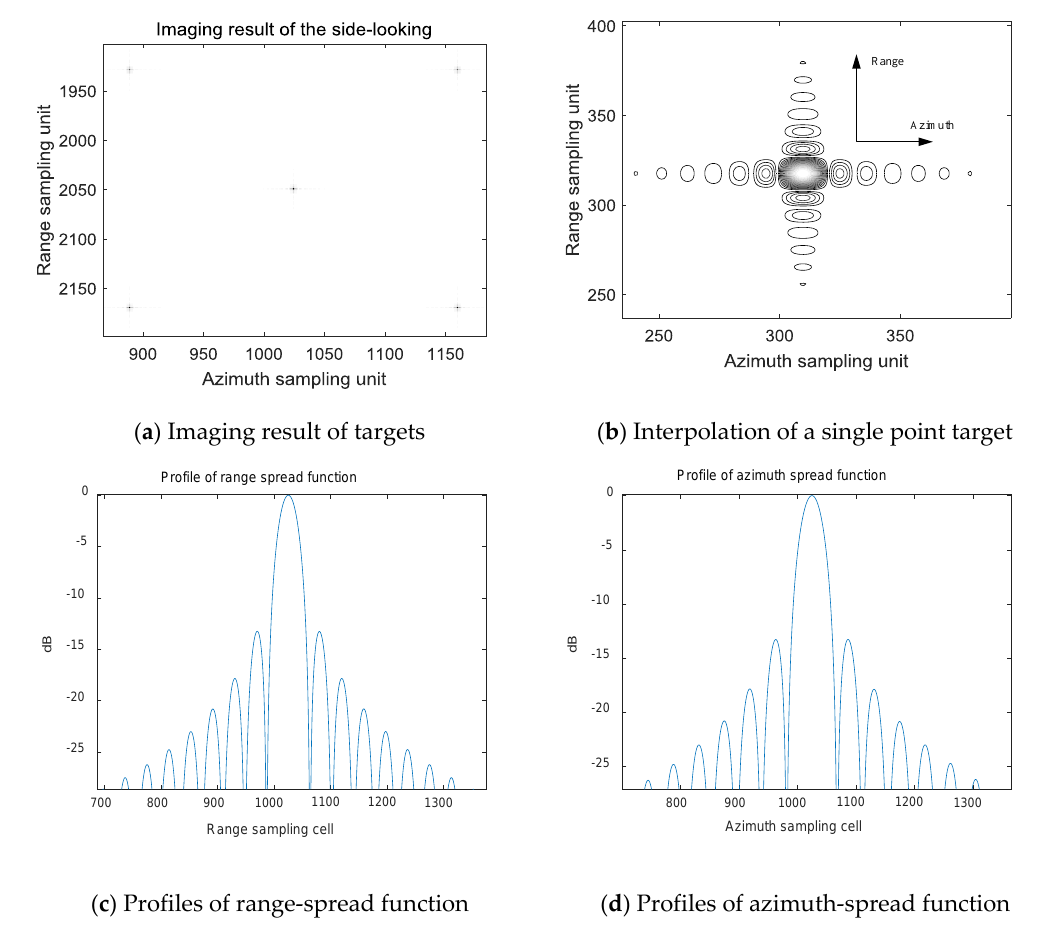
Figure 12. Imaging result of the side-looking beam.